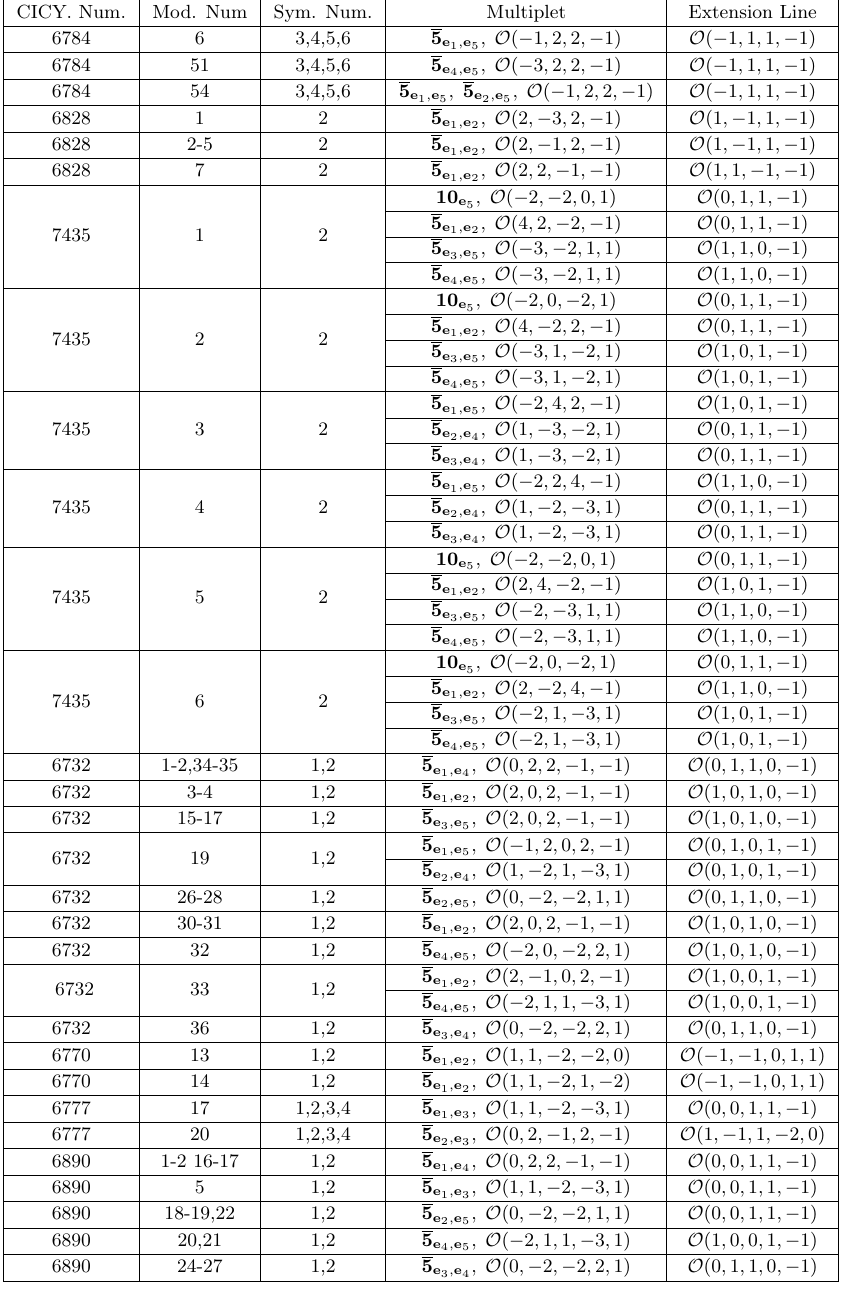
Table 3 . Heterotic line bundle standard models whose spectrum can be forced to jump by a hidden sector bundle of the form (4.3). The (cid:12)rst column speci(cid:12)es the CICY number of the manifold involved (according to the standard list [75, 104]). The second and third columns specify the standard model numbers involved and the symmetries that are used in their construction according to the data sets provided in [19, 20, 105] and [88, 104] respectively. The fourth column gives an example of the component of the spectrum which can be forced to jump and the line bundle to which it is associated. Finally, the (cid:12)fth column gives an example of an L which, when utilized in (4.3) would result in the change of spectrum being